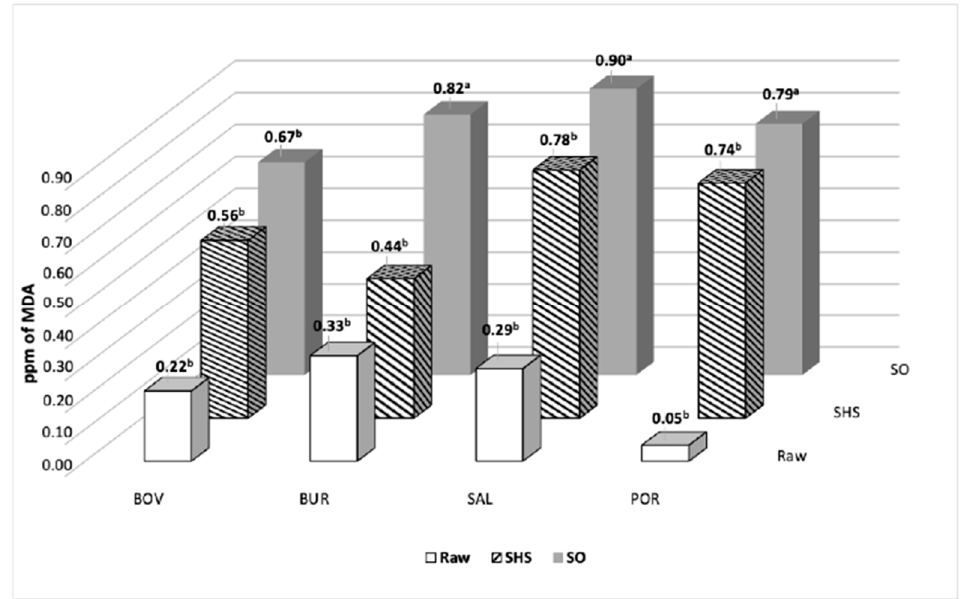
Figure 2. TBARS values in raw and cooked samples (ppm of MDA). BOV, bovine steak; BUR, hamburger; SAL, salmon fillet; POR, pork steak. Different letters within sample kinds correspond to different values for p < 0.05.